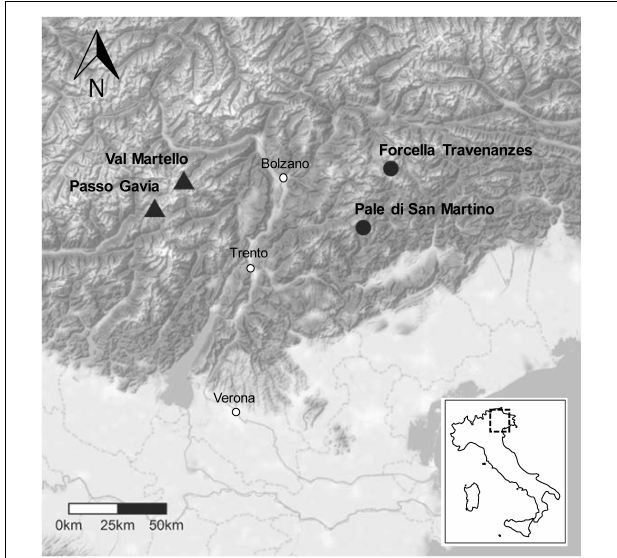
FIGURE 1 | Location of the four snowbed sites in the Italian eastern Alps. Circles and triangles represent calcareous and siliceous sites,